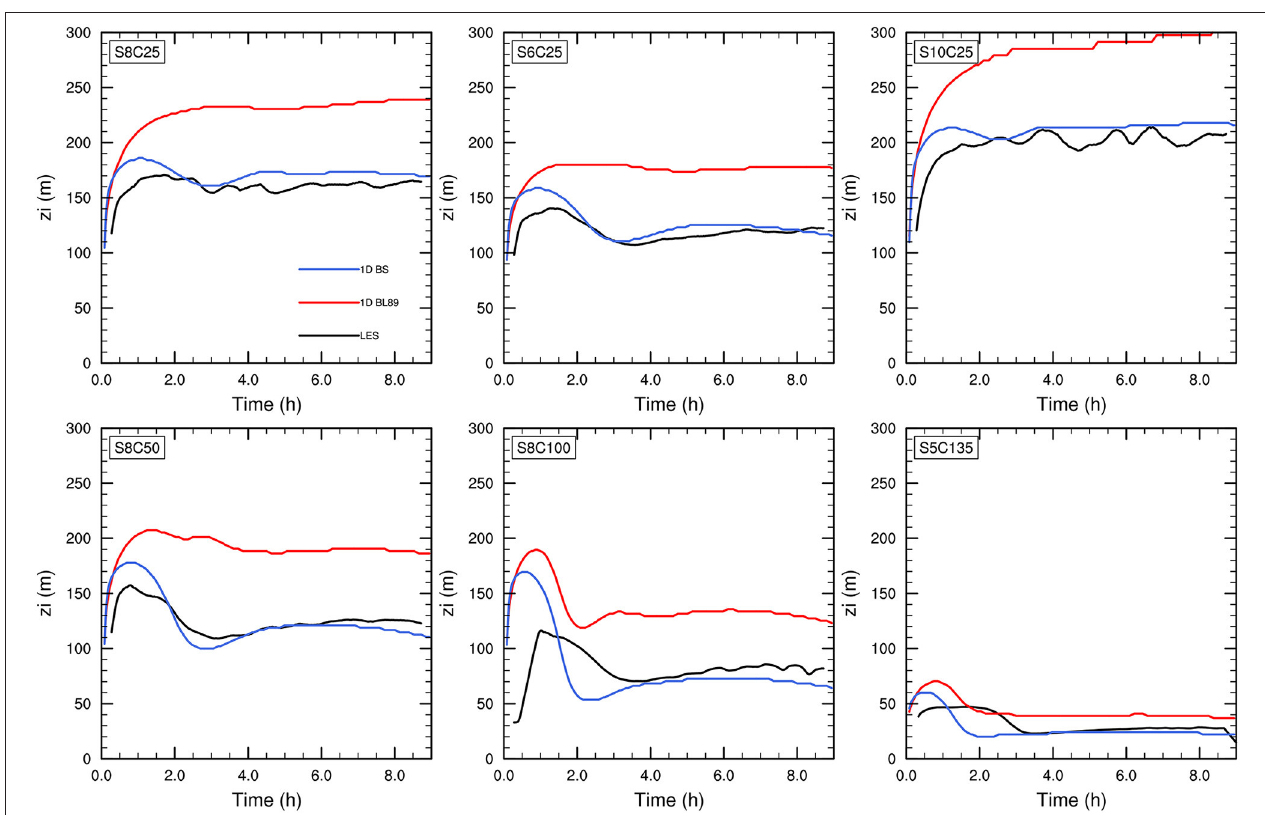
FIGURE 5 | Time evolution of the boundary-layer height z i (Equation 28) for the stably stratified cases (S8C25, S8C50, S8C100, S5C135, S6C25, and S10C25; see Table 1 ) for the LESs (black), the SCMs with the BL89 length (red), and the SCMs with the BS length (blue). For the LESs, the data are smoothed by a moving average.